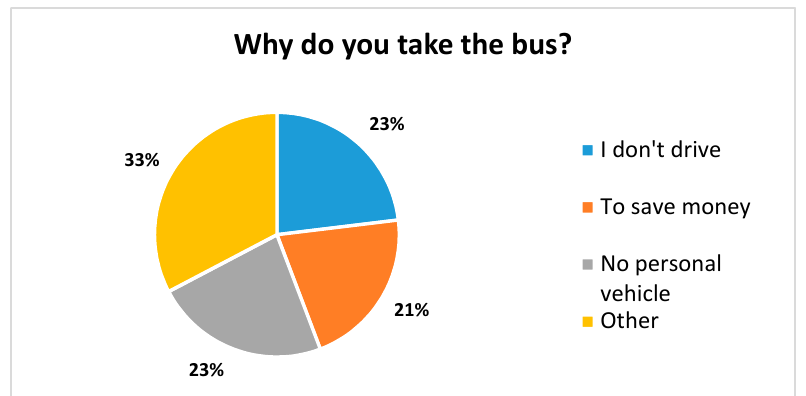
Figure 4. The main purpose for riding the bus. Int. J. Environ. Res. Public Health 2017 , 14 , 629